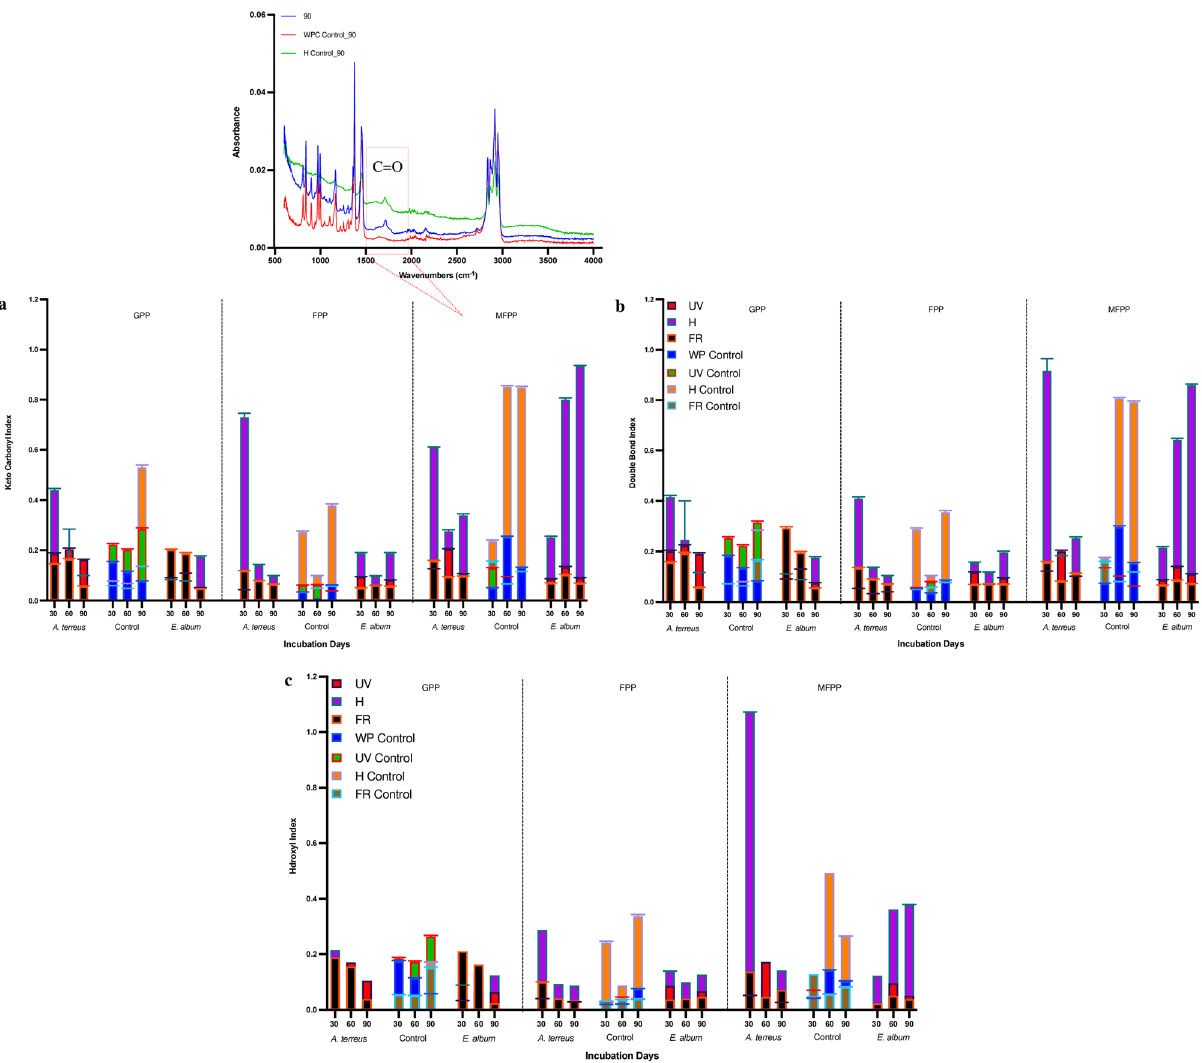
Fig. 5 FTIR analyses. a Keto carbonyl index as a function of time of different PP samples. b Double bond index as a function of pre-treatments of PP samples. c Hydroxyl index as a function of time of different PP samples. GPP: PP granule; FPP: PP fi lm, MFPP PP metallized fi lm, WPC without pre-treatment, UV UV treatment, H heat treatment, FR Fenton reagent treatment. The error bars represent the standard error of mean (sem) of the triplicate reading for the keto and double bond